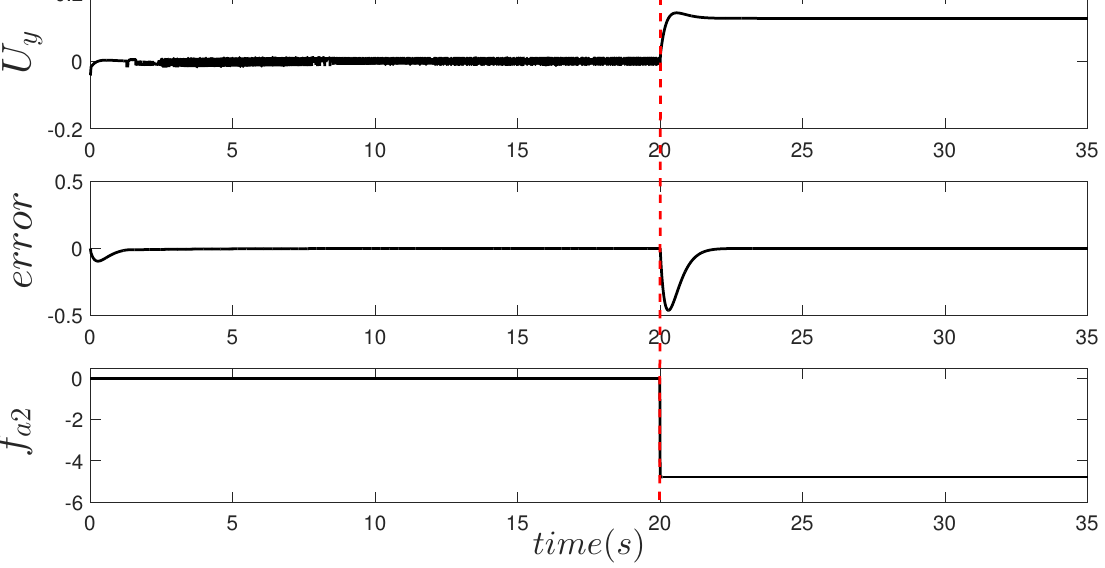
Figure 7. Behavior of the control signal, regulation error and fault in both states, where the fault is present in the actuator two, that is, f a 2